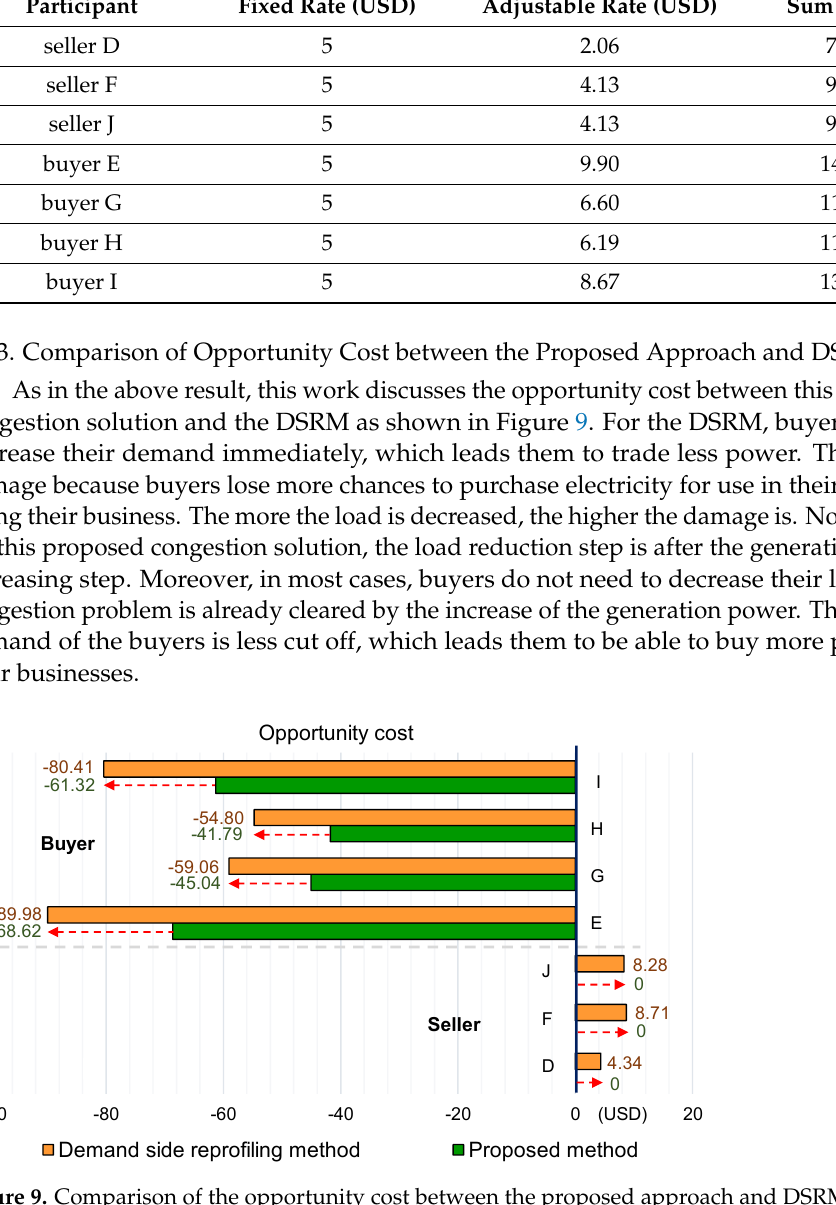
Table 13. The compensation rate for power adjustment. Table 13 . The compensation rate for power adjustment .